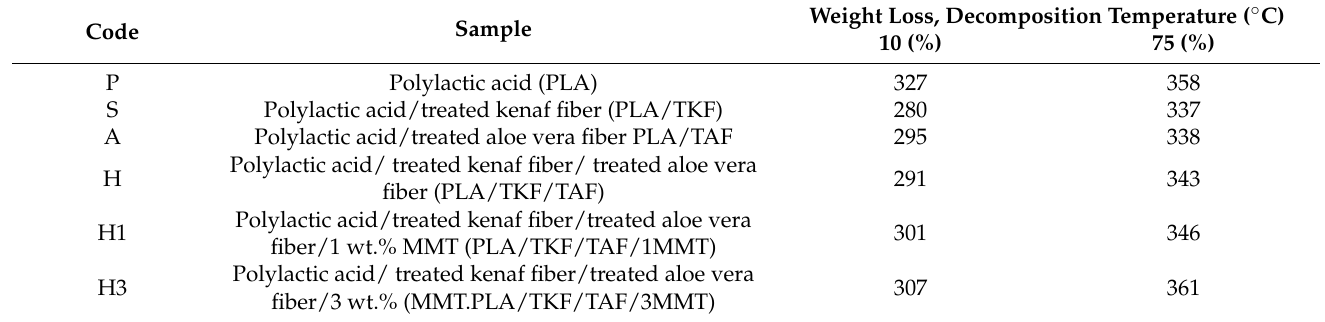
Table 7. TGA Characterisation of P, S, A, H, H1, and H3